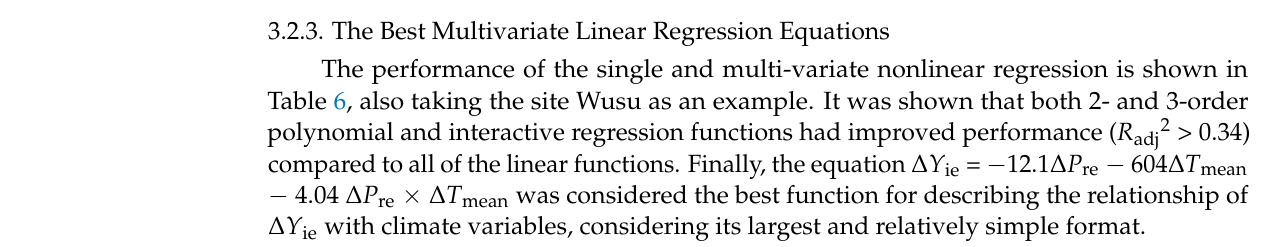
Table 6. Performance of different nonlinear regression functions between ∆ Y ie and climatic variables at the site Wusu. Model